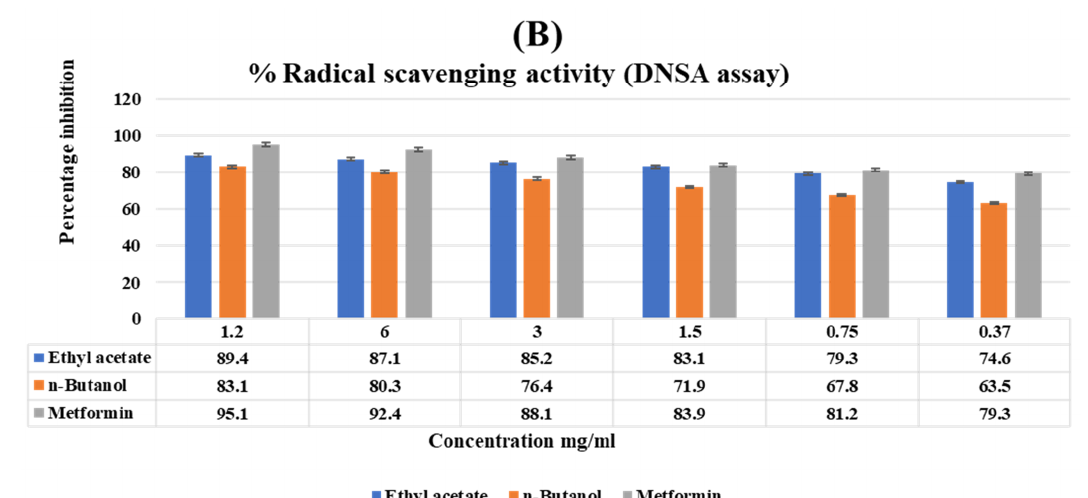
Figure 5. Showing the antidiabetic activity of the fractions of T. vulgaris plant extract. Vertical bars represent the mean ± S.E. The values were expressed in the mean ± SD of triplicates, and all values were statistically significant at p < 0.05. ( A ) Starch iodine assay. ( B ) DNSA assay.